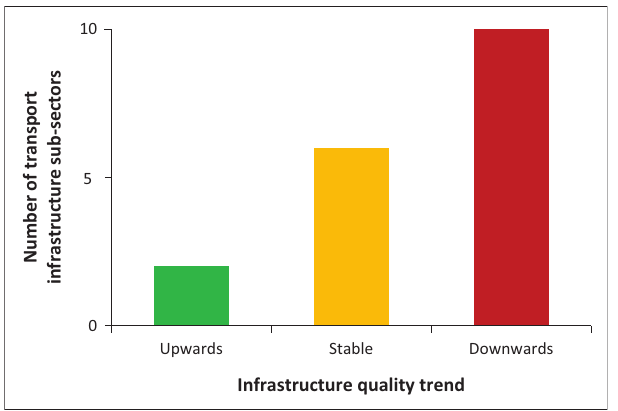
FIGURE 2: Trend in transport infrastructure provision for South Africa.